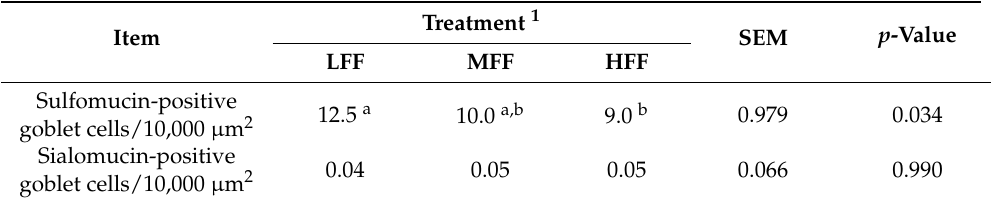
Figure 2. Representative high iron diamine (black stain) and Alcian blue (turquoise stain) histo- chemistry images taken at 20X to differentiate sulfomucins and sialomucins, respectively. Pigs were inoculated with Brachyspira hyodysenteriae and fed a ( A ) lowly fermentable diet (LFF), an ( B ) interme- diate fermentability diet (MFF), and a ( C ) highly fermentable diet (HFF). Pigs were euthanized at days post inoculation (dpi) 42. In general, colon sections were dominated by sulfomucins, with very few goblet cells containing sialomucins being present unless pigs were still clinically afflicted at the time of necropsy (panel D ). If sialomucin-positive cells were present, these were primarily limited to the base of the crypts. Table 5. Sulfomucin- and sialomucin-positive goblet cells in the colon at 42 days post inoculation of pigs inoculated with Brachyspira hyodysenteriae and fed a lowly fermentable diet (LFF), an intermediate fermentability diet (MFF), and a highly fermentable diet